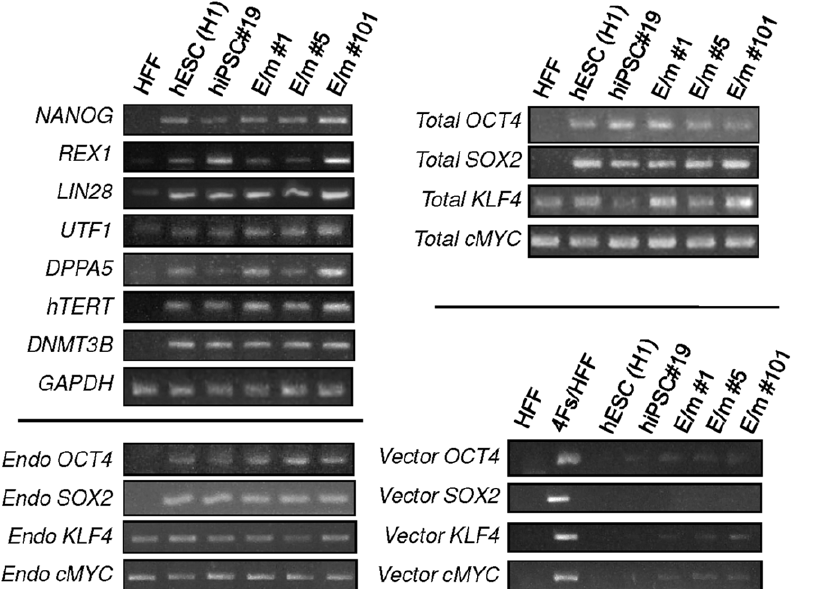
Figure 5. Molecular characterization of hiPSCs transduced with the reporter vector containing miRNA targets. Total RNA was isolated using QIAGEN’s RNeasy Mini kit from HFFs transduced with (4Fs/HFF) or without 4 reprogramming factors (HFF), hESCs (H1), and 4 different hiPSC clones transduced with (E/m # 1, E/m # 5, and E/m # 101) or without (hiPSC # 19) the reporter vector encoding EGFP miR-T/mCherry miR-T. Total RNA (250 ng) was reverse-transcribed using QIAGEN’s Omniscript reverse transcription kit and used as a template in subsequent PCR with 5-PRIME’s HotMaster Taq DNA polymerase. PCR products were analyzed on a 2% agarose gel. Glyceraldehyde-3-phosphate dehydrogenase (GAPDH) was used as an internal control.